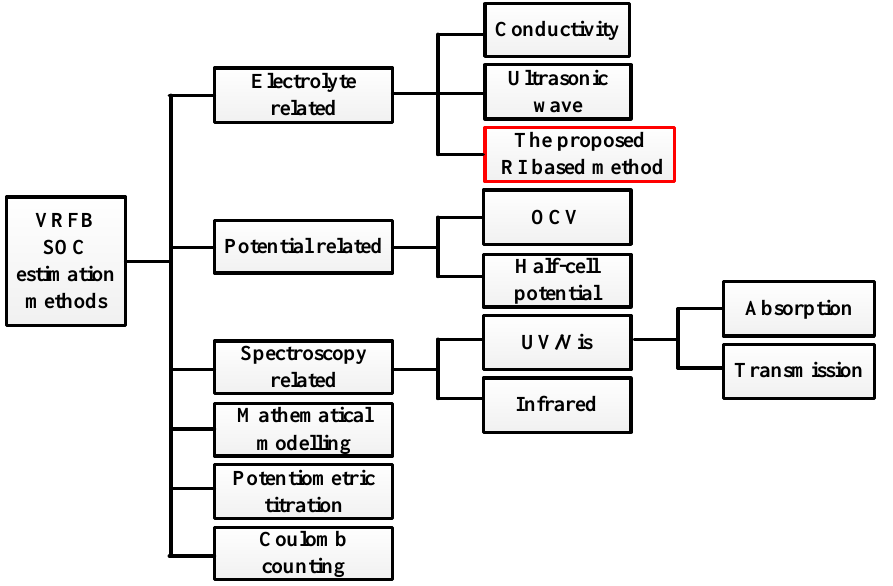
Figure 1. Categories of reported vanadium redox flow battery’s (VRFB’s) state-of-charge (SOC) estimating methods.